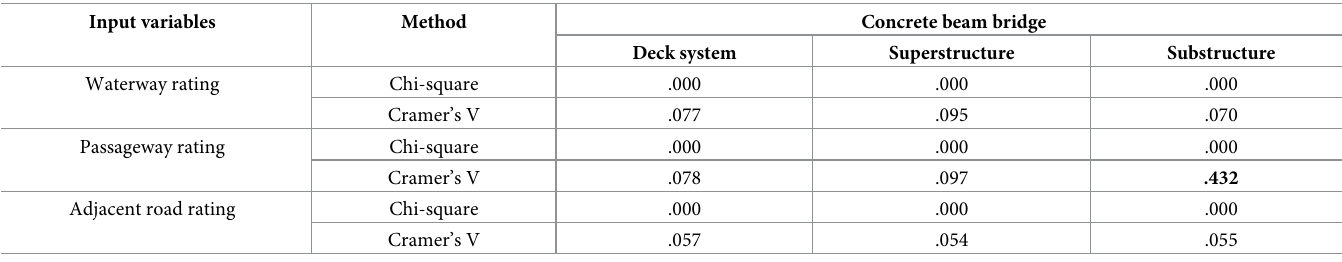
Table 10. Chi-square and Cramer’s V test results between adjacent asset